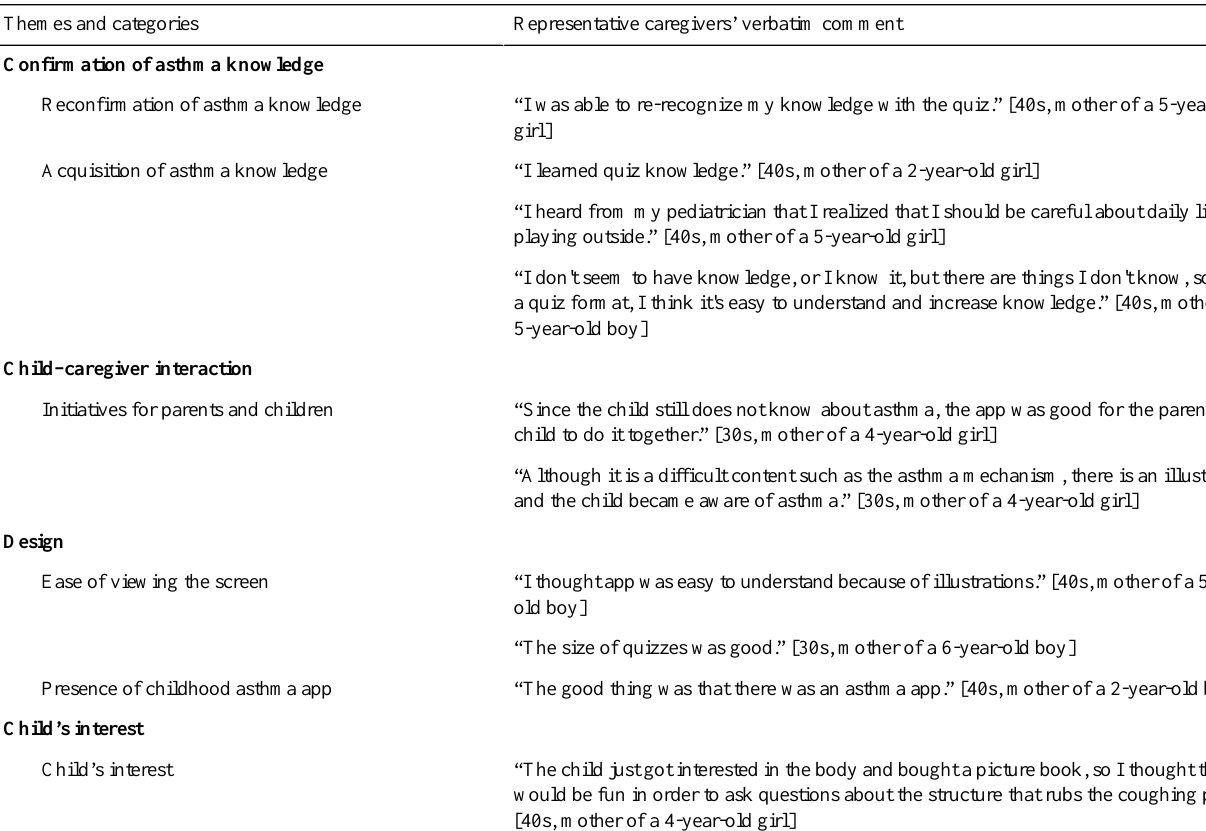
Table 2. Good aspects for children younger than 7 years old with asthma and their caregivers.